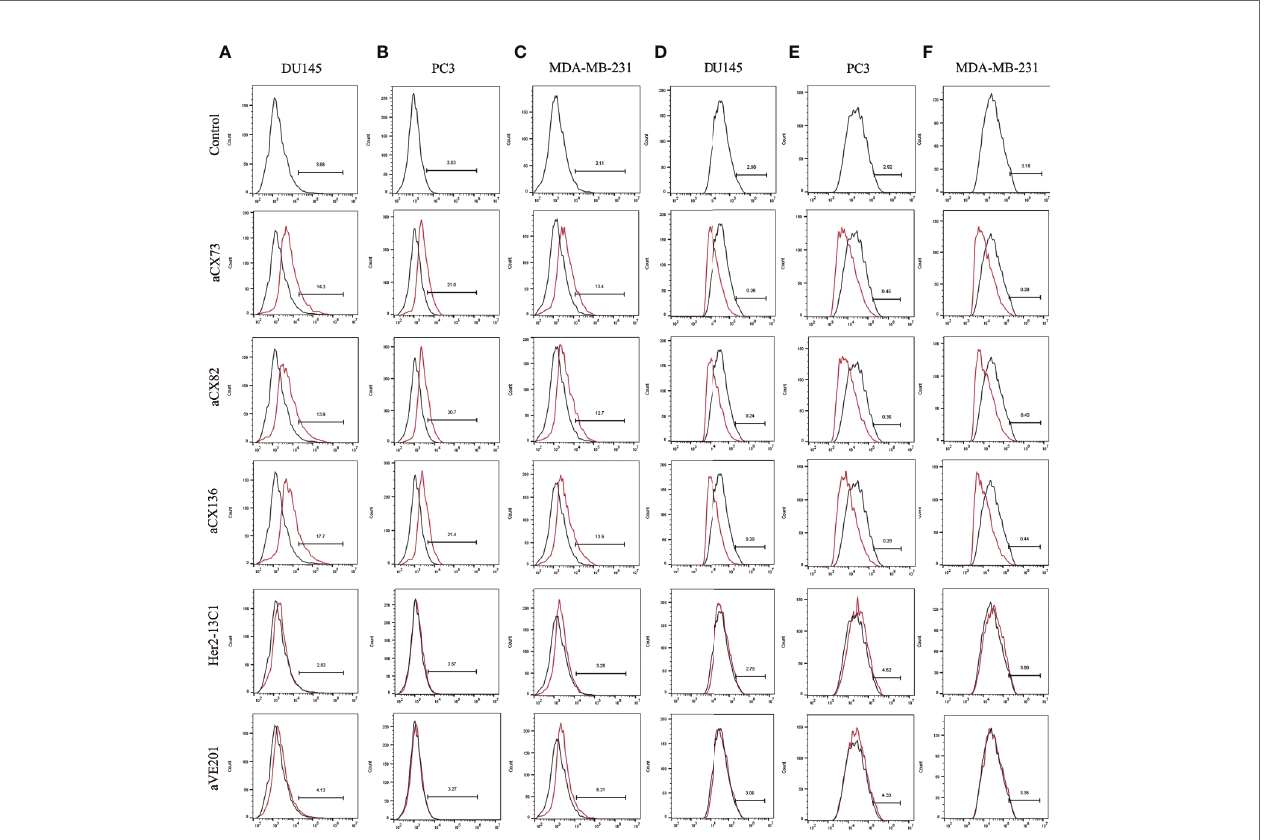
FIGURE 5 | Expression of the apoptosis-related proteins Bax and Bcl-2 was detected by fl ow cytometry. Bax expression was examined after DU145 (A) , PC3 (B) , and MDA-MB-231 (C) were treated for 48 h with the three anti-CXCR4 scFvs (aCX73, aCX82, and aCX136). Bcl-2 expression was also tested in DU145 (D) , PC3 (E) , and MDA-MB-231 (F) . The PBS control and the two negative control antibodies (Her2-13C1 and aVE201) were also